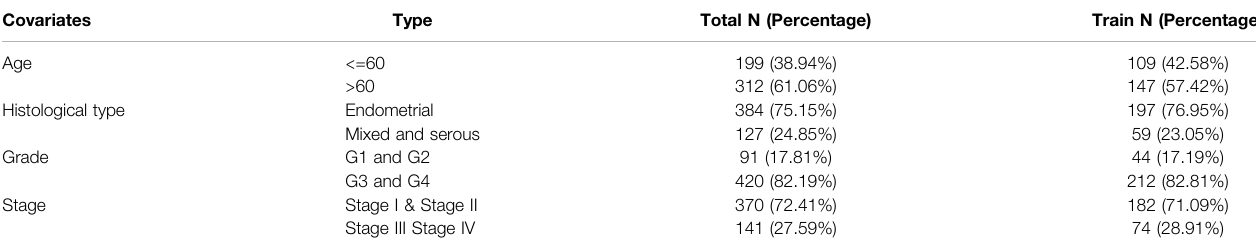
TABLE 1 | Clinical information of the included UCEC patients in